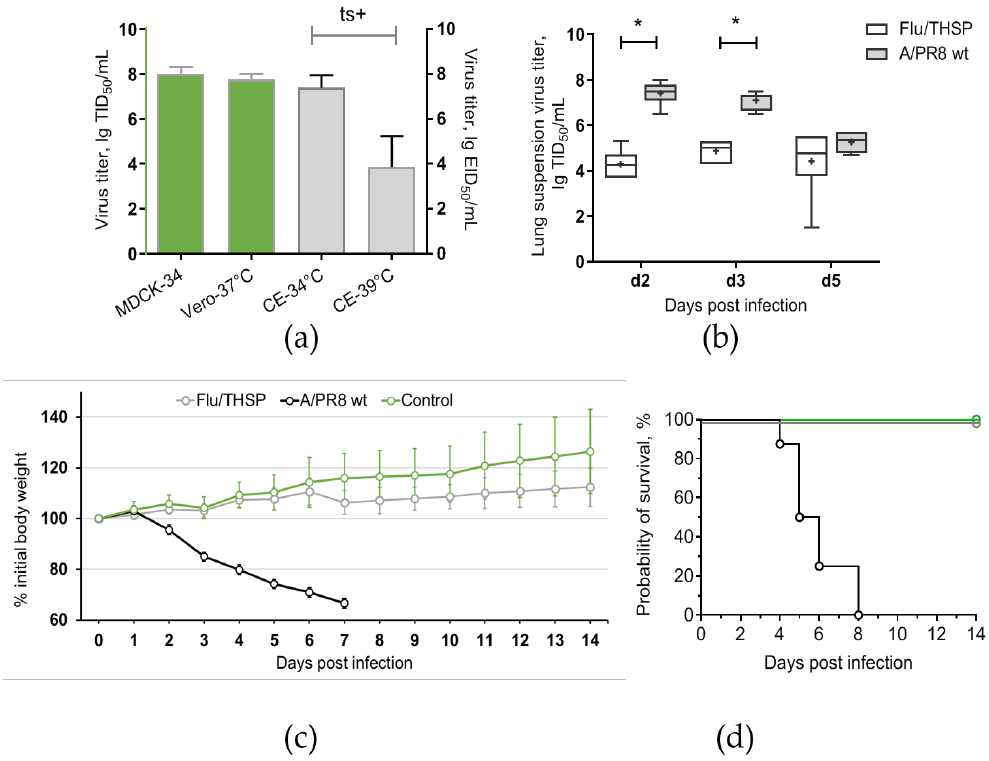
Figure 2. Reproductive properties of the Flu/THSP recombinant virus. ( a ) Virus replication in cell cultures and CE at permissive (34 C and 37 C) and elevated (39 C) temperatures; ( b ) Virus replication in mouse lungs. Mice were infected with 6.0 lg EID 50 of Flu/THSP virus (gray circles) or 5.0 lg EID 50 of wild-type A/PR8 strain (black circles) and euthanized on days two, three, and five to determine viral load by titration of 10% lung suspension in MDCK cells. The data presented are mean values from six mice per group ± SD (error bars). Each dot represents an individual mouse. The difference between groups was analyzed by two-way ANOVA with the Bonferroni post-hoc-test (* p < 0.0001); ( c , d ) Weight dynamics and survival of mice infected with 6.0 lg EID 50 of Flu/THSP virus (gray circles) or wild-type A/PR8 strain (black circles). Intact mice were used as control (green circles). Presented are group means with SD at indicated time post-infection (n = 8).